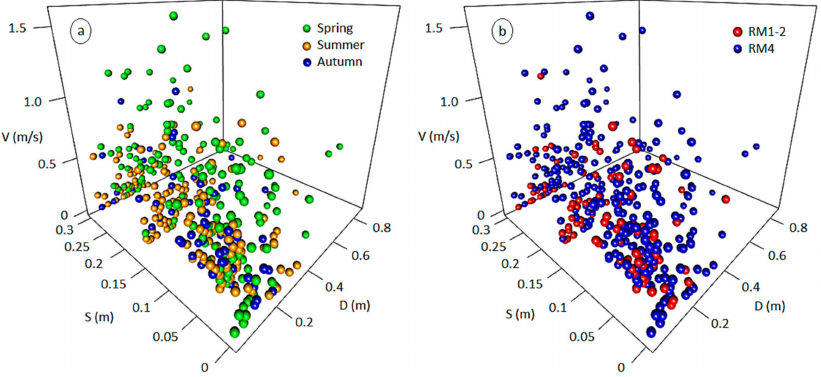
Figure 1. Three-dimensional representation of the 380 microhabitat samples of the benthos-GR dataset spanning three seasons ( a ) and two river types ( b ). V: flow velocity, D: water depth, S: substrate